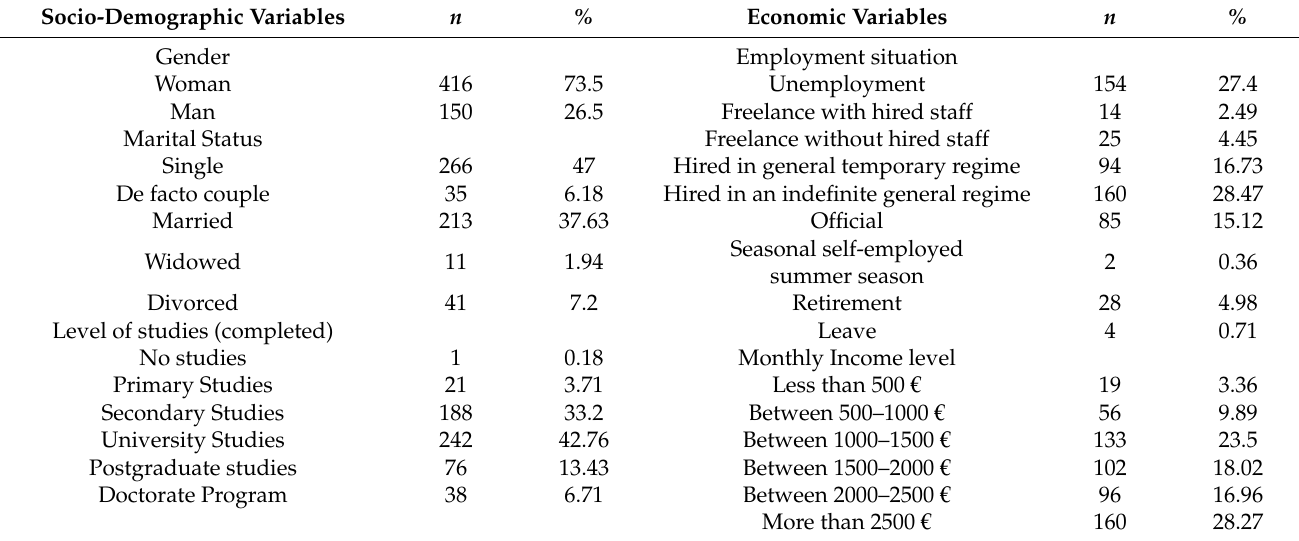
Table 1. Description of the sample for economic and socio-demographic data before the state of alarm. Socio-Demographic